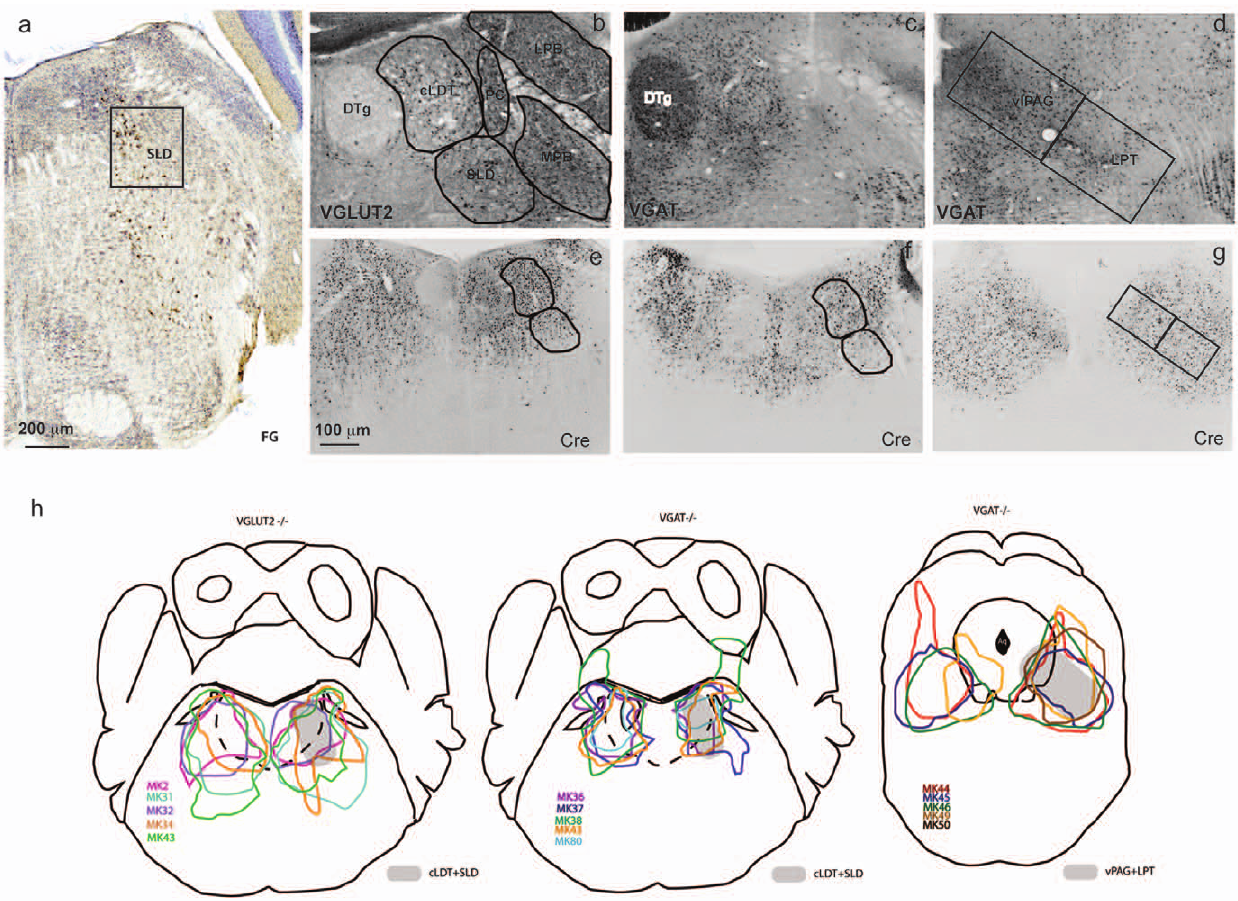
Figure 1. Distribution of VGLUT2-, VGAT- and Cre-positive neurons in the pontine tegmentum. (a) Retrograde-labeled neurons from the spinal cord mark the mouse SLD. VGLUT2-positive neurons labeled by green fluorescent protein (GFP) are seen primarily in the cLDT-SLD, precoeruleus (PC) and parabrachial nuclei (PB) (b), whereas VGAT-positive neurons (also a GFP proxy) are seen primarily in the cLDT and dorsal tegmental nucleus (DTg) but not in the PB-PC (c). VGAT is also highly expressed in the vlPAG-LPT (d). Typical Cre labeled patterns after the AAV-Cre injections targeting the cLDT-SLD are shown in (e) for VGLUT2 deletion and (f–g) for VGAT deletion. The AAV-cre filled areas from each VGLUT2 and VGAT deletion cases are outlined in